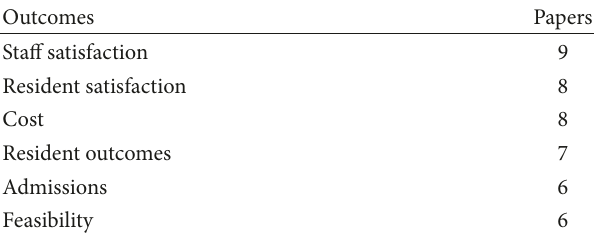
Table 5: Papers grouped by outcomes examined. Papers may appear in more than one category if they discuss more than one of the